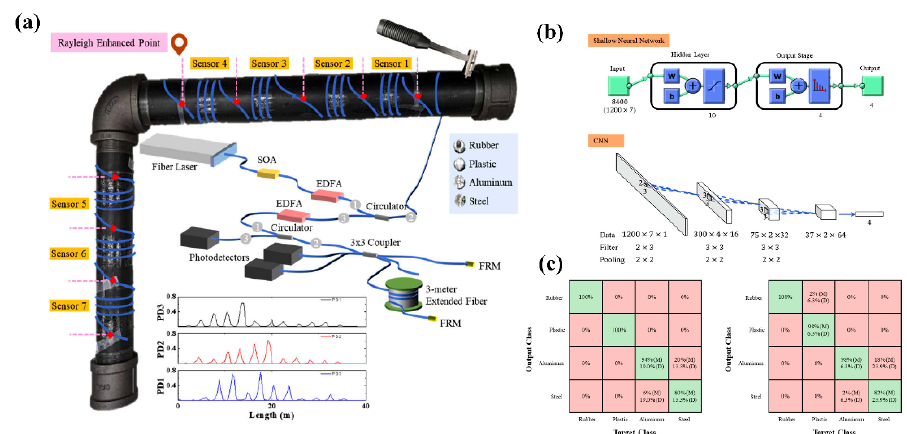
Figure 18. Schematic diagram of a pipeline survey [79]: ( a ) schematic diagram of DAS system for pipeline protection; ( b ) architectures of neural networks in the pipeline protection system; ( c ) the confusion matrix of four acoustic events.